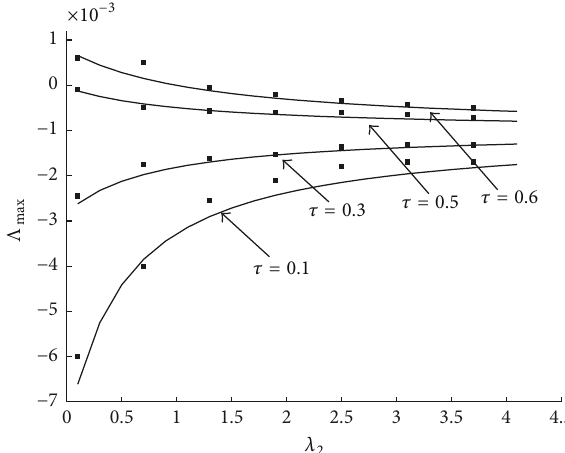
Figure 2: The largest Lyapunov exponent Λ max as function of transition rate 𝜆 2 . The lines are obtained from numerical solution of (37) while the symbols are obtained from direct simulation of original system